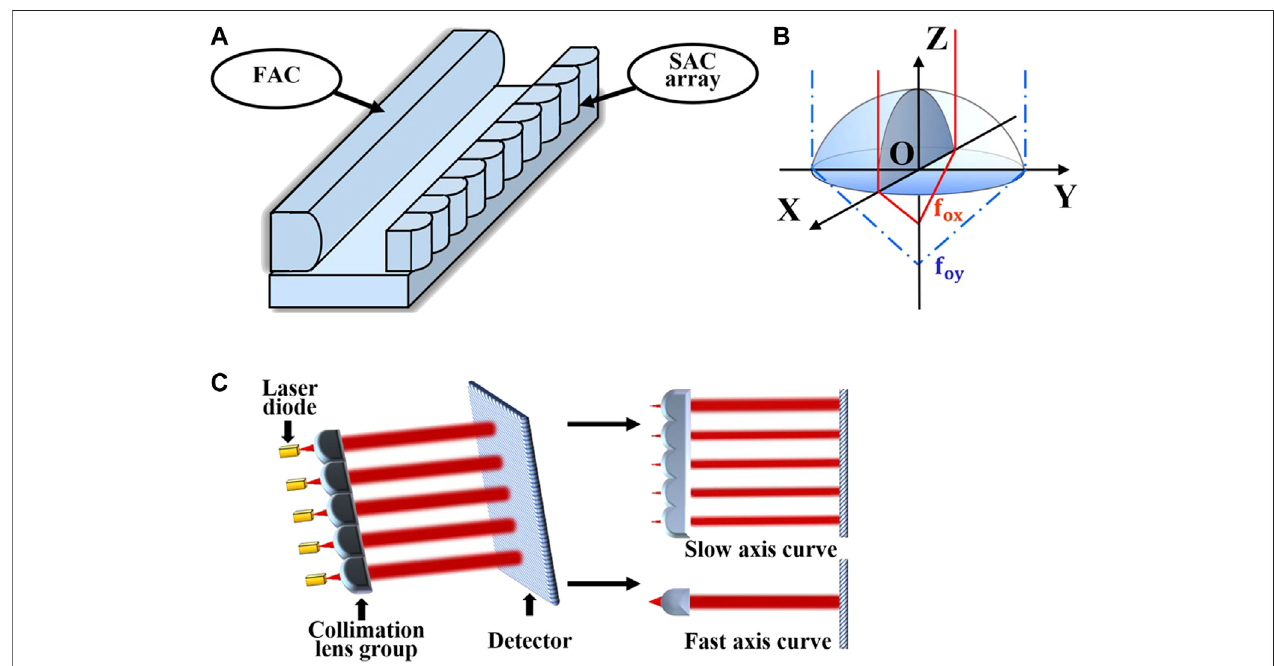
FIGURE 4 | Various integrated collimating lenses: (A) FAC and SAC lenses combined into one optical device. Adapted from [10]; (B) One lens can collimate the divergence angle of a beam in two directions. Adapted from [11]; (C) One set of lenses can collimate the divergence angle of the Bar beams in two directions. Adapted from [1].